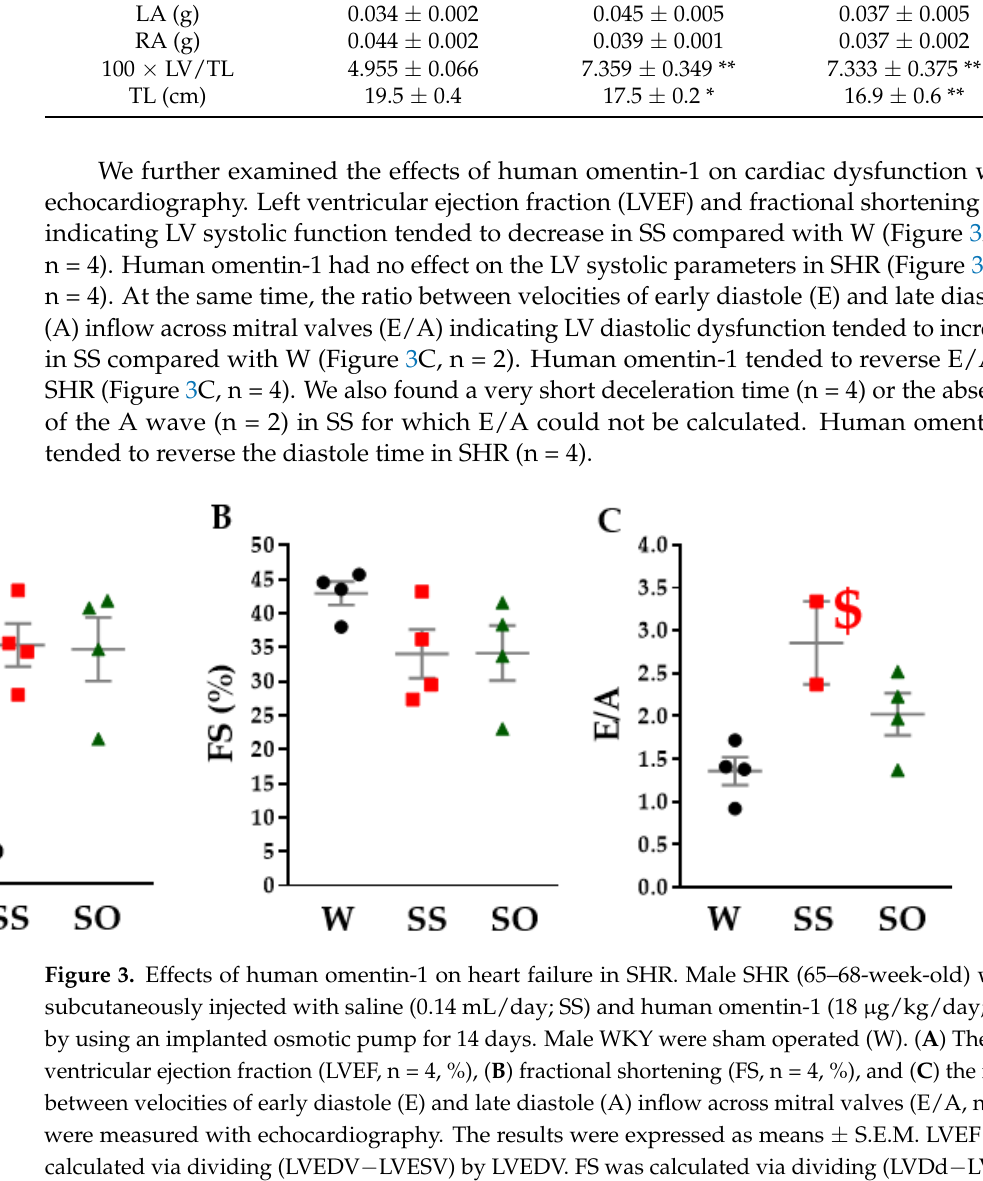
Table 1. Effects of human omentin-1 on cardiac hypertrophy in spontaneously hypertensive rats (SHR). The heart was isolated from male SHR (65–68-week-old) subcutaneously injected with saline (0.14 mL/day, n = 4; SS) and human omentin-1 (18 µ g/kg/day, n = 4; SO) by using an implanted osmotic pump for 14 days or sham operated male Wistar Kyoto rats (WKY) (n = 4; W). The wet weight (g) of the left ventricle (LV), left atrium (LA), right ventricle (RV), and right atrium (RA), as well as tail length (TL, cm) were measured. The LV weight was corrected by TL. Results were expressed as means ± standard error of the mean (S.E.M.). * p < 0.05, ** p < 0.01 vs. W (One-way ANOVA followed by Bonferroni’s post-hoc test). W (n = 4) SS (n = 4) SO (n = 4) Whole heart (g) 1.301 ± 0.009 1.575 ± 0.050 * 1.531 ± 0.082 LV (g) 0.967 ± 0.005